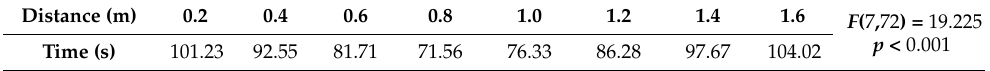
Table 4. Average time to complete tasks after dividing the depth and distance range of operation interaction information.